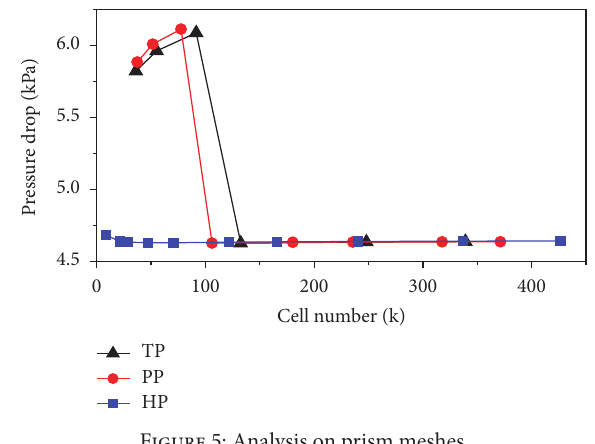
Figure 5: Analysis on prism meshes.